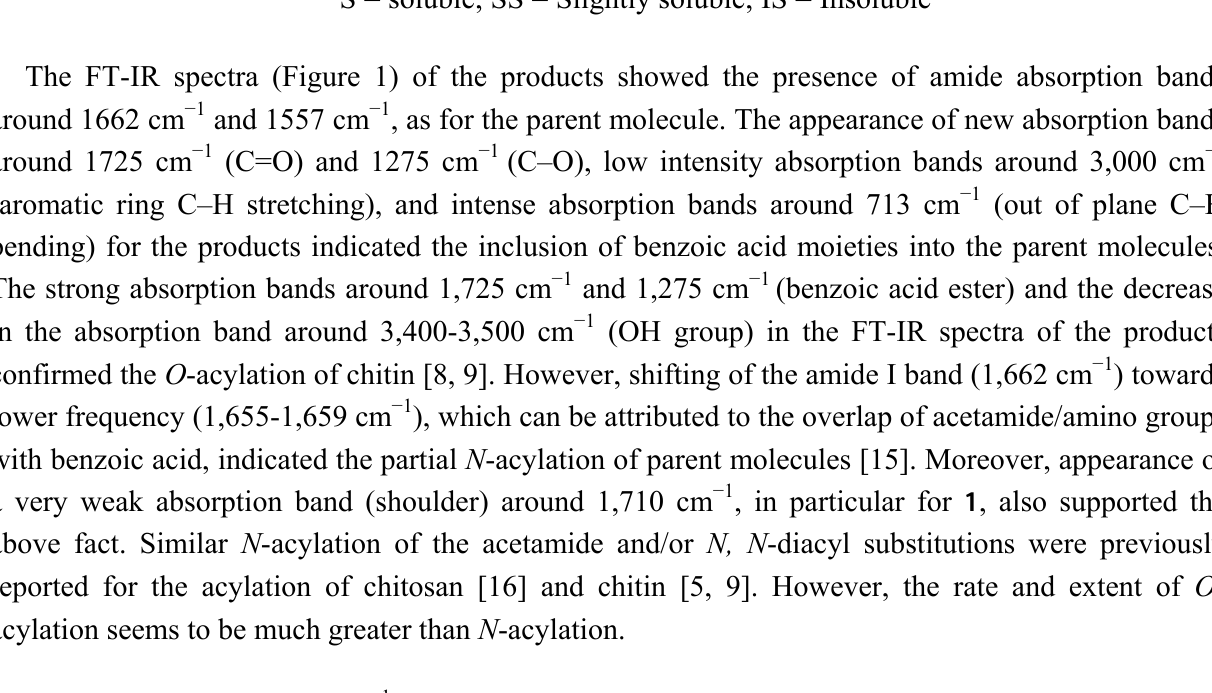
Figure 2. 1 H-NMR spectra of chitin benzoic acid ester (